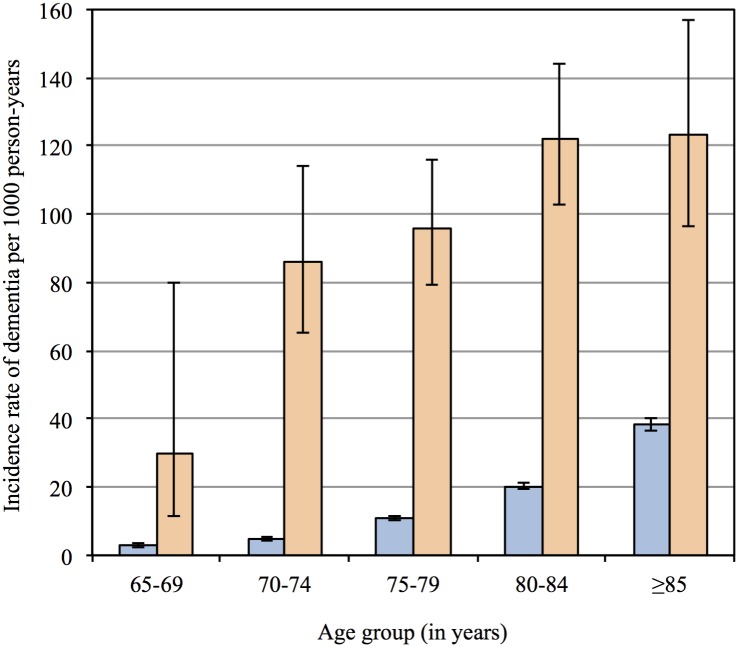
The bars depict the incidence rate of dementia per 1000 person-years for each age group, and the whiskers represent the 95% confidence interval of the rates.The left and right bars for each age group show the results for men without and with Parkinson’s disease respectively.